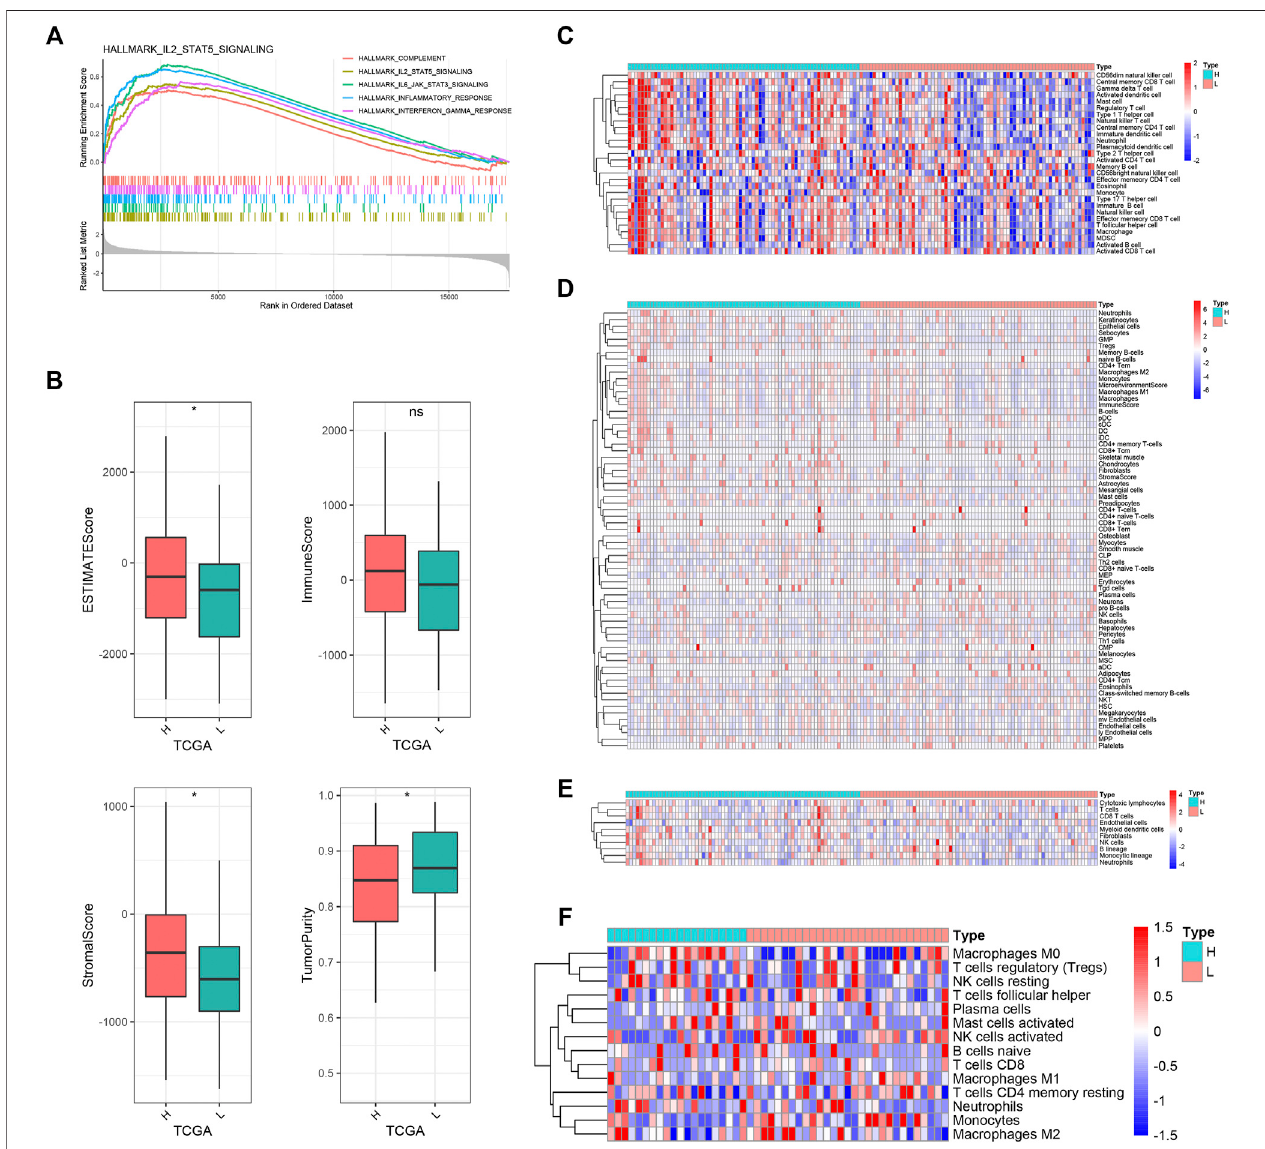
FIGURE 6 | Biological functions and immune landscape regarding PRLS. (A) The enriched gene sets in HALLMARK collection by the high-risk groups. Each line representing one particular gene set with unique color, and upregulated genes located in the left approaching the origin of the coordinates; by contrast the downregulated lay on the right of x -axis. Only gene sets with normalized enrichment score |NES| > 2 and false discovery rate (FDR) < 0.01 were considered signi fi cant. Only several leading gene sets were displayed in the plot. (B) The distribution difference of ESTIMATE, immune, stromal, and tumor purity enrichment score between the high-risk and low-risk groups. ns p > 0.05, * p < 0.05. (C – F) Heatmaps of immune cells in fi ltration in the high-risk and low-risk groups based on ssGSEA, xCell, MCPcounter, and CIBERSORT algorithms, respectively.